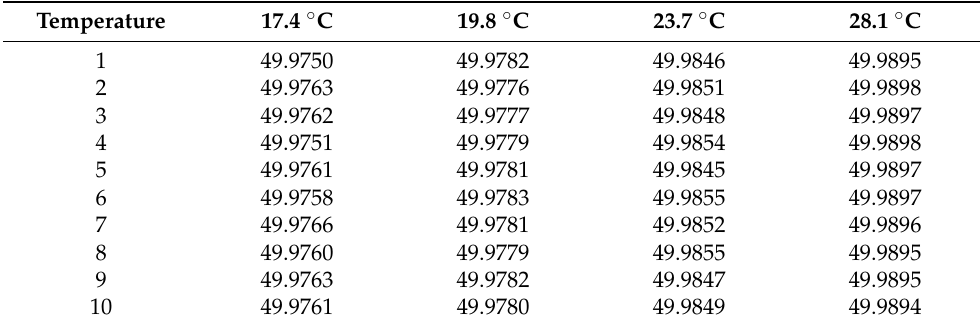
Table 2. Part measurement data of main journal J1 at different temperatures /mm.